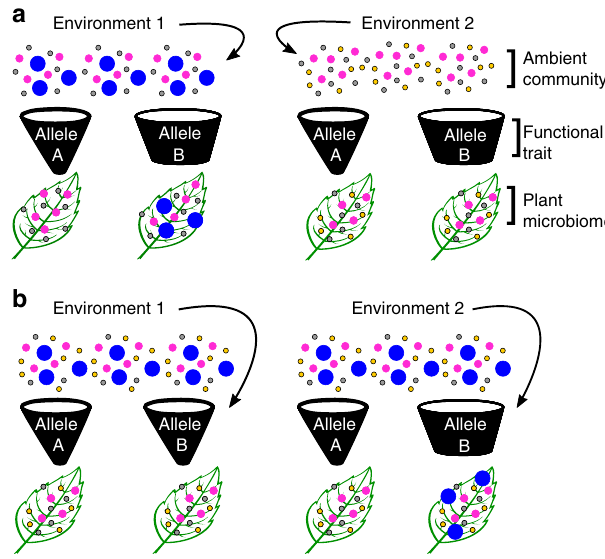
Figure 7 | Multiple non-mutually exclusive hypothetical mechanisms could cause genotype–environment interactions for microbiome composition. Each panel shows the ambient microbial community for two environments (abstracted as coloured circles); the expressed phenotypes of two different host genotypes (abstracted as funnels that are labelled with the plant genotype); and the resulting microbiome of the genetically distinct plants in each environment. In a the genetic variant is expressed in both environments (that is, there is no phenotypic plasticity) but it affects only certain microbes, which are absent from Environment 2. As a result, genetic diversity for the trait is expressed in both environments, but genetic diversity for the microbiome is only observed in Environment 1. In b , environmental variation alters the phenotype expressed by plant genotype B, but not plant genotype A (that is, there is genetic variation for phenotypic plasticity, or a genotype–environment interaction for the functional trait). As a result, host genotype affects microbiome composition only in Environment 2, even though the ambient communities are identical in both